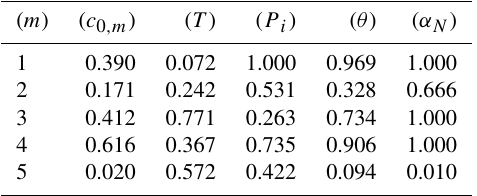
Table 1. Normalised cluster centre values after data